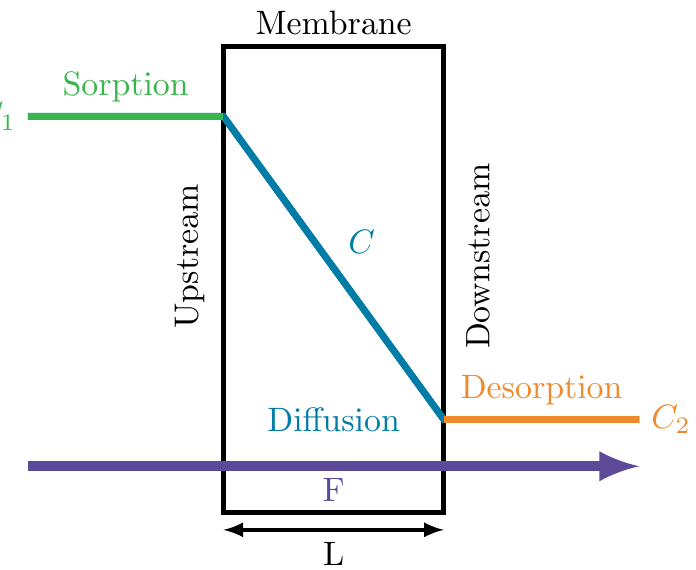
Figure 1. Sketch of the three-step process of mass permeation flow F through a dense polymer membrane with thickness L : sorption at the upstream side of the membrane with C 1 as boundary condition for Equation (4), diffusion through the membrane with the concentration distribution C inside the membrane, and desorption at the downstream side of the membrane with C 2 as the boundary